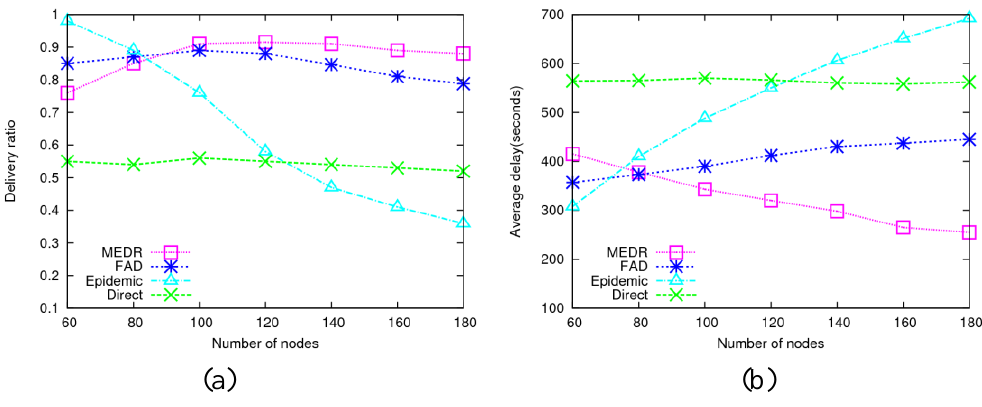
Figure 5. Impact of node density. (a) Average delivery ratio; (b) Average